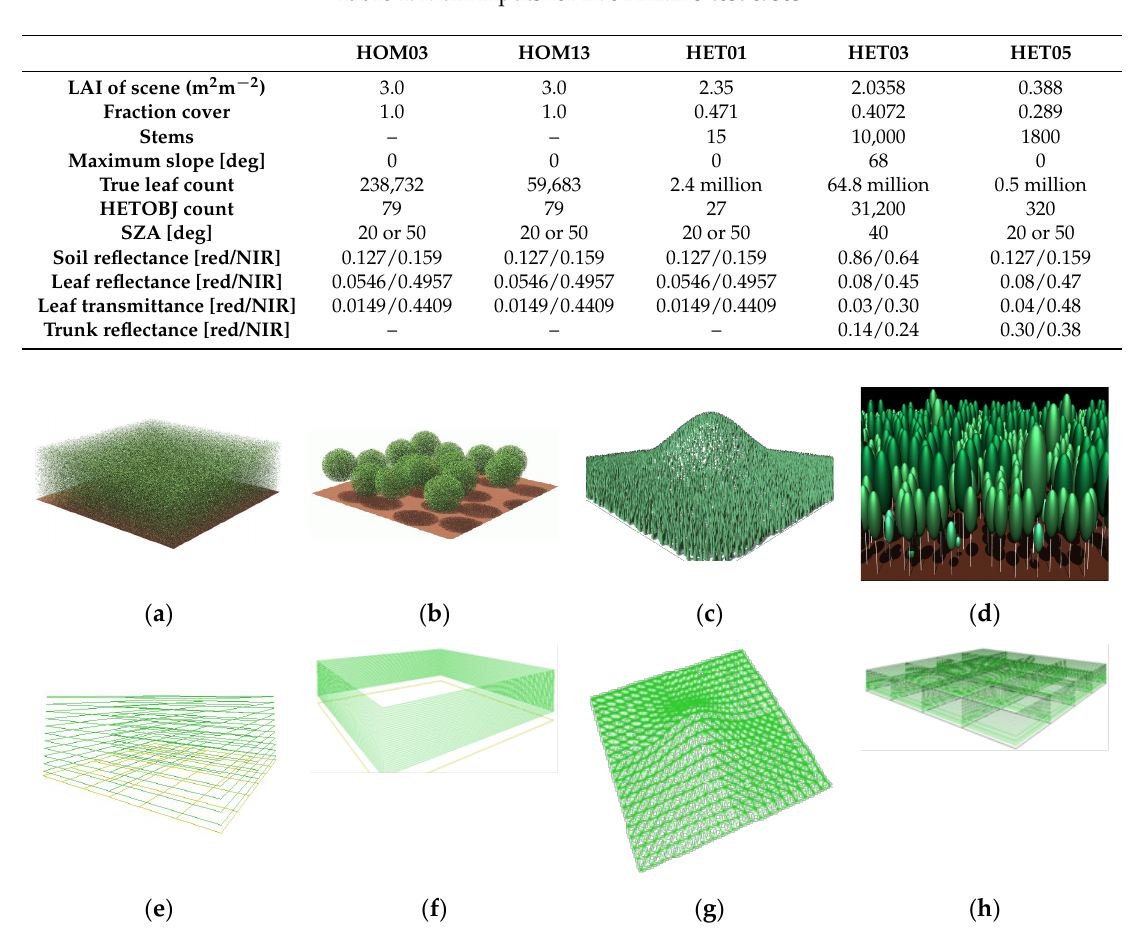
Table 1. Main inputs for five RAMI-3 test cases.